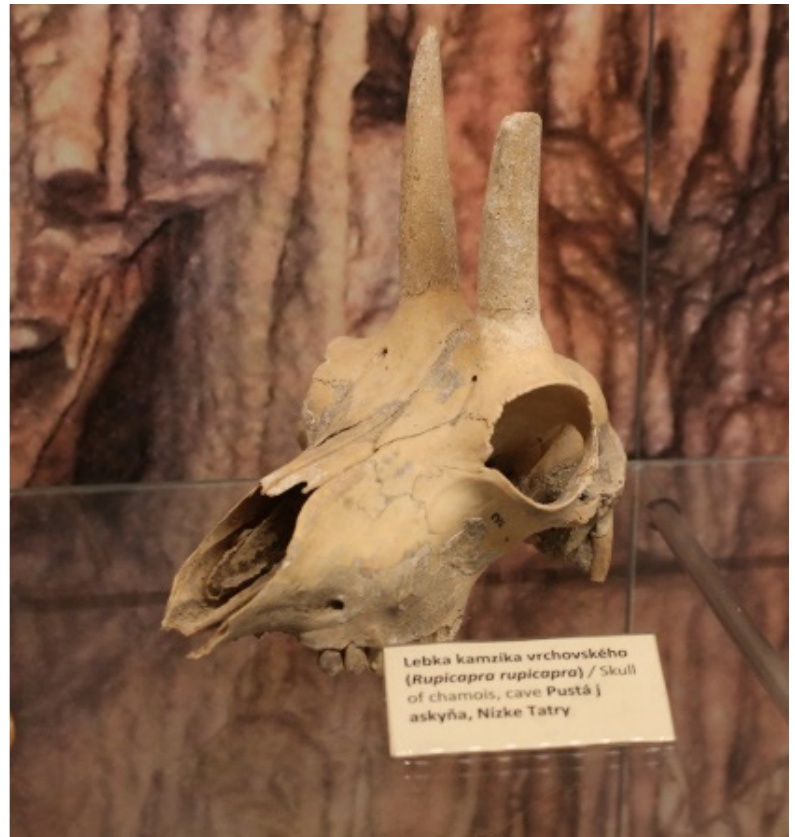
Figure 4. Alpine chamois skull found in the Pustá Cave in the Ď umbier Tatras, deposited in the exposition of the Slovak Museum of Nature Protection and Speleology in L. Mikuláš (photo: P. Urban).